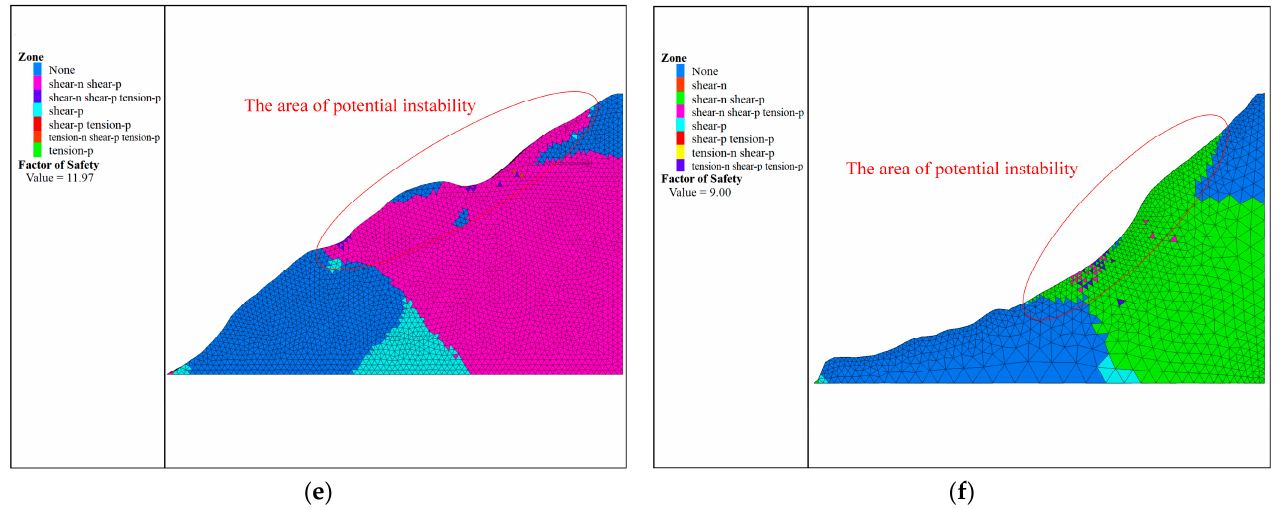
Figure 6. Calculation results of the strength reduction method: ( a ) R1; ( b ) R3; ( c ) R4; ( d ) R8; ( e ) Z1; ( f ) Z4.